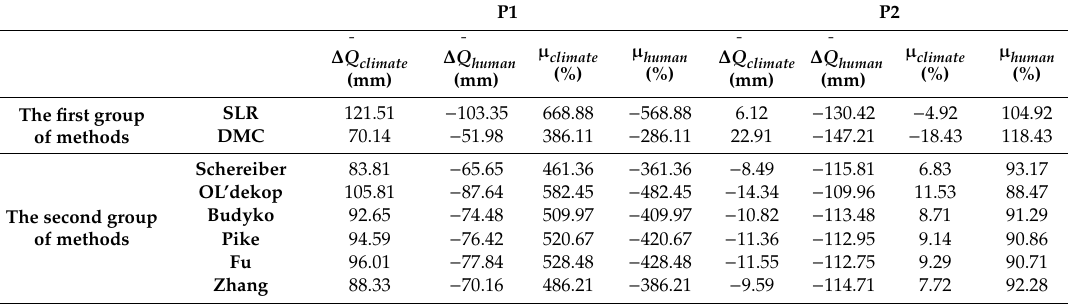
Table 3. Runo ff depth alteration caused by climate change and human activities, calculated with eight